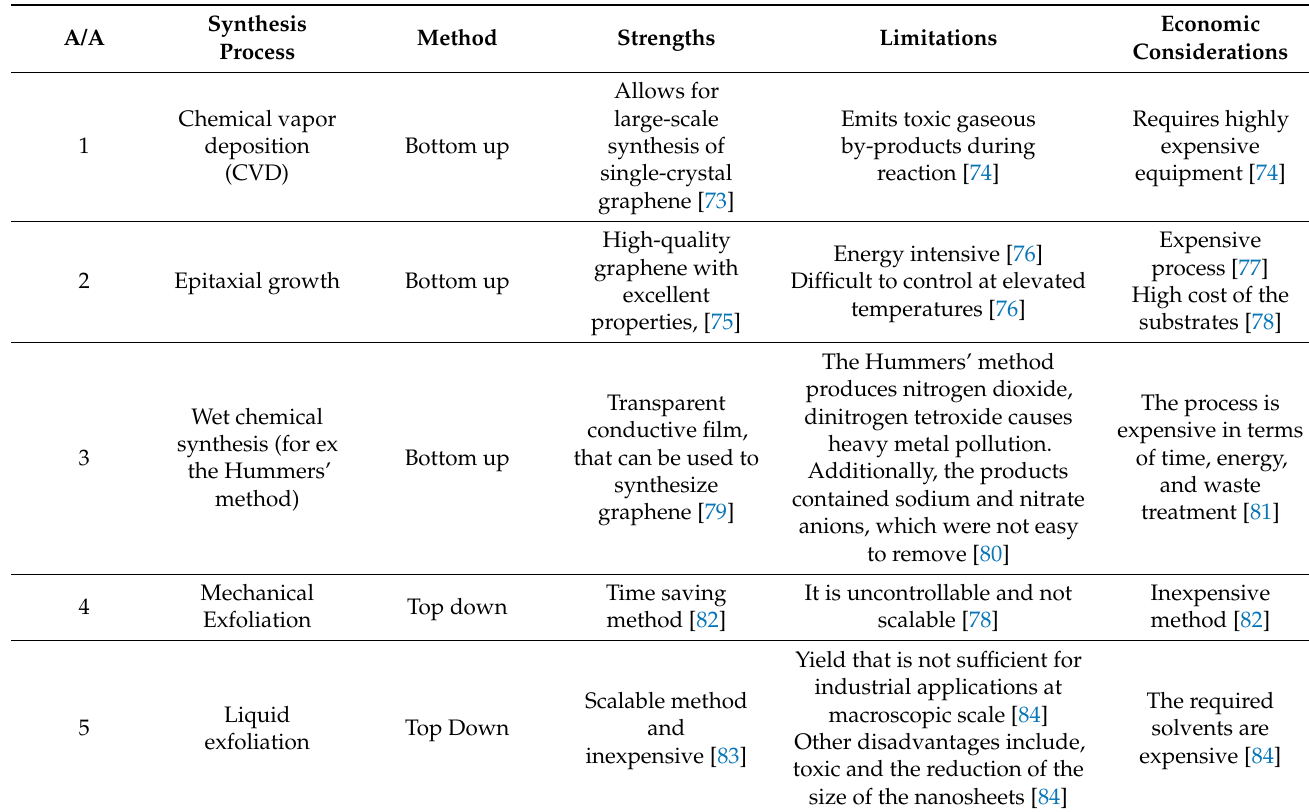
Table 1. Strengths and Limitations of various methods used to synthesize